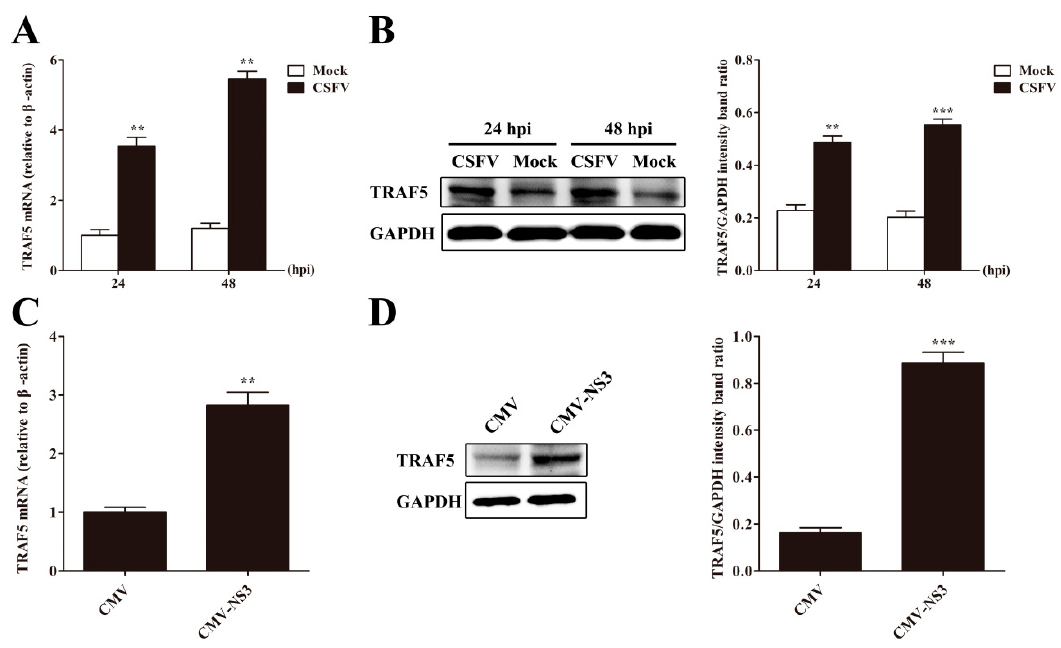
Figure 3. CSFV or NS3 promotes TRAF5 expression. ( A ) TRAF5 mRNA expression in CSFV-infected PAMs. PAMs were mock-infected or CSFV-infected. TRAF5 mRNA was analyzed by RT-qPCR at 24 and 48 hpi; ( B ) TRAF5 protein expression in CSFV-infected PAMs. TRAF5 protein levels